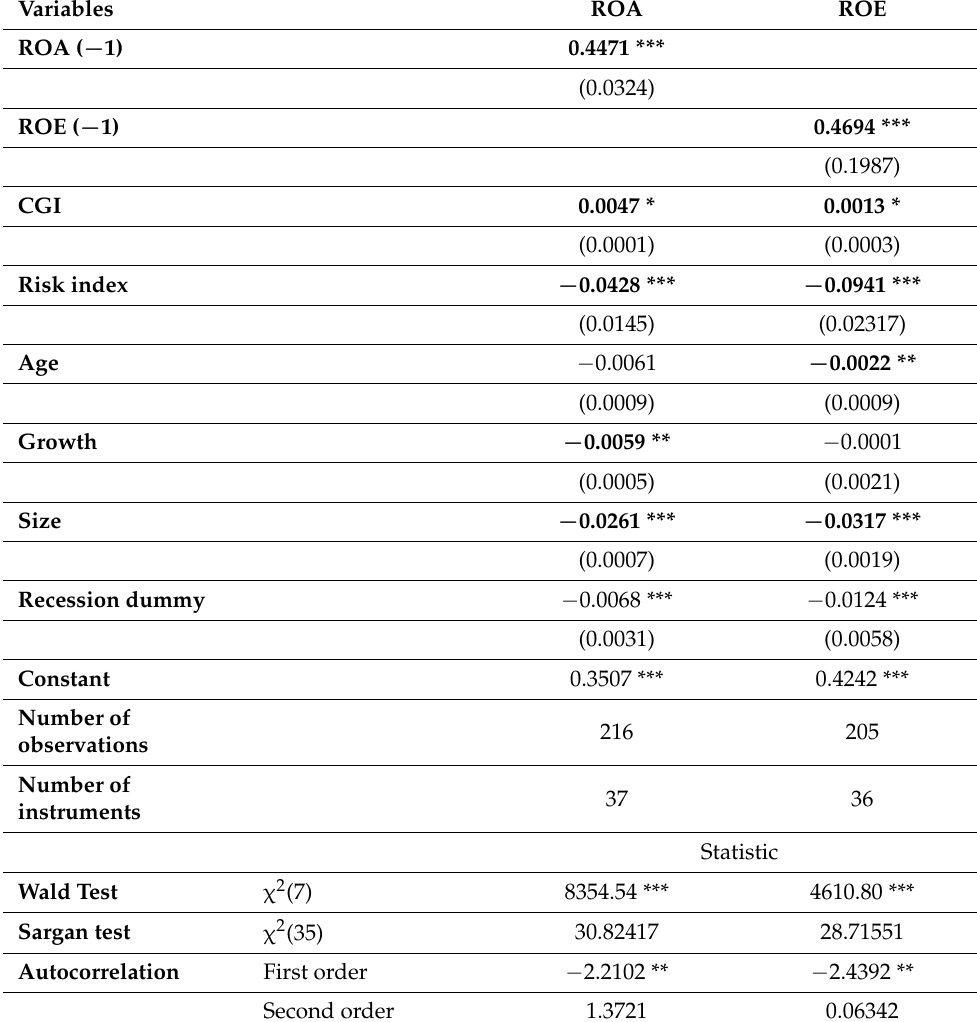
Table 5. Results of (Arellano-Bond) GMM estimation of ROA and ROE on risk index and CGI.